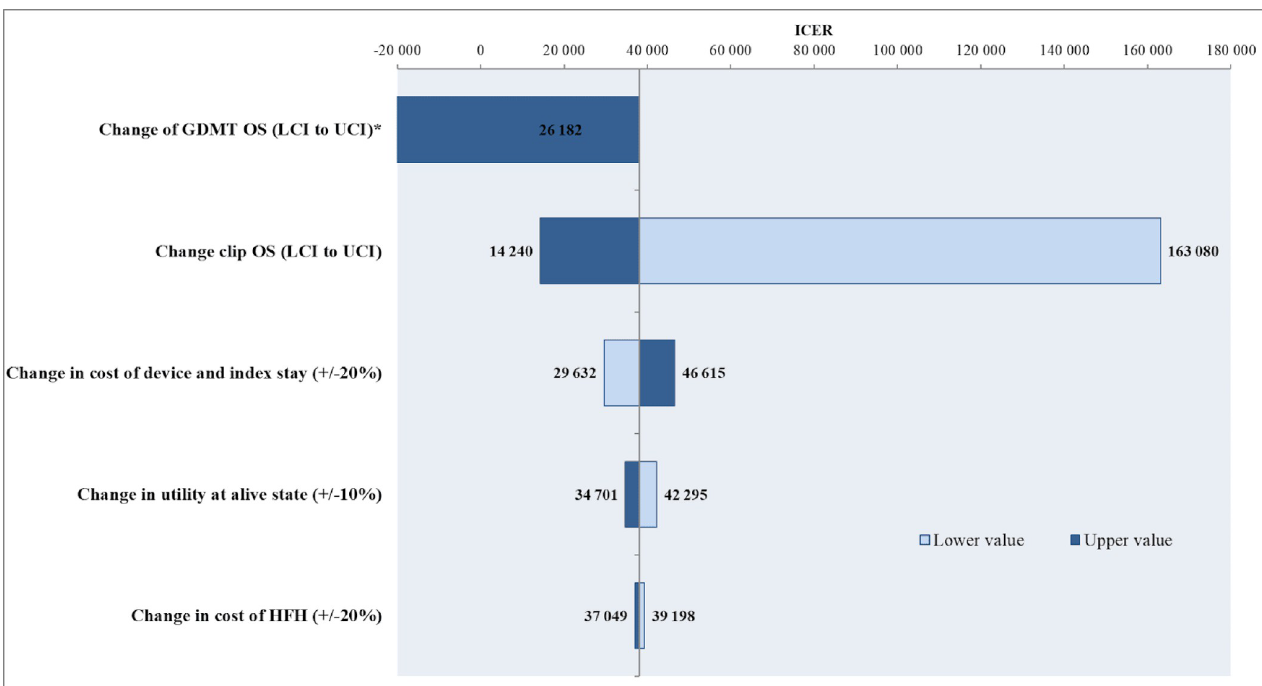
Fig 5. Tornado plot of univariate sensitivity analysis. � Using UCI value for OS in the GDMT arm, incremental effectiveness (Mitraclip relative to GDMT) becomes negative while incremental cost remains positive, resulting in a negative ICER (-7,550,815) denoting that the Mitraclip strategy is dominated; please note that the horizontal bar corresponding to the use of LCI value for OS in the GDMT arm (ICER of 26,182) is hidden below the one for UCI value for OS in the GDMT arm.